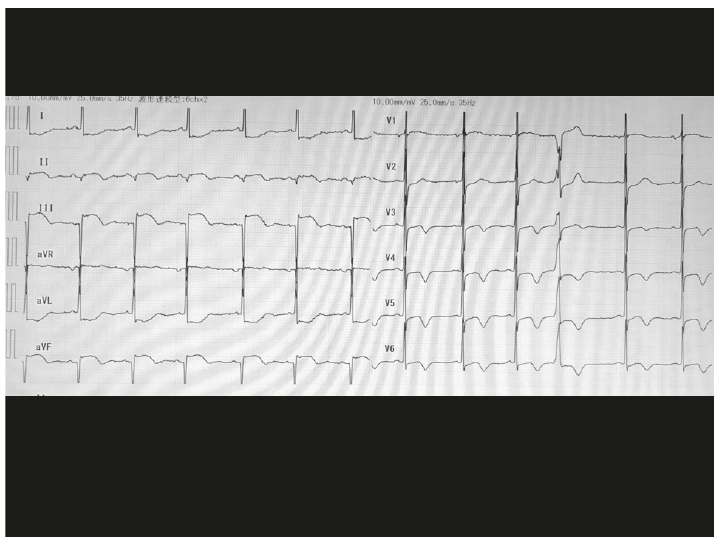
Figure 1: Electrocardiography on arrival. The electrocardiogram showed ST segment elevation in leads II, III and aVF.